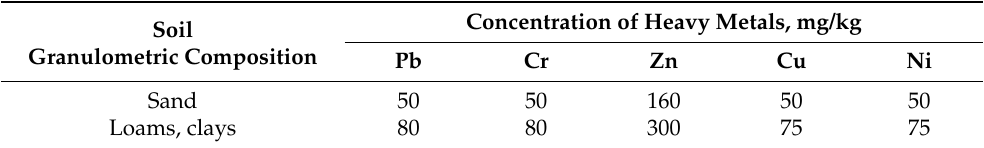
Table 2. The maximum permissible concentration of heavy metals (MPC) in soil according to the Lithuanian environmental normative document